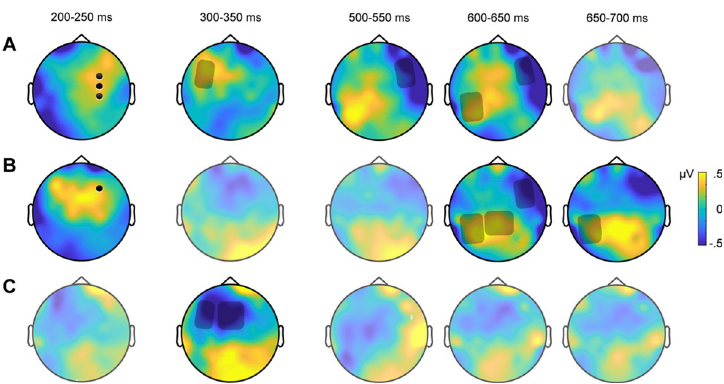
Fig 1. Topographic representations of the ERP differences between (A) IFVs and TVs, (B) IFVs and UVs, and (C) TVs and UVs. Darkened areas and black dots represent regions and electrodes where voice conditions were significantly different. No significant difference were found on light-shaded